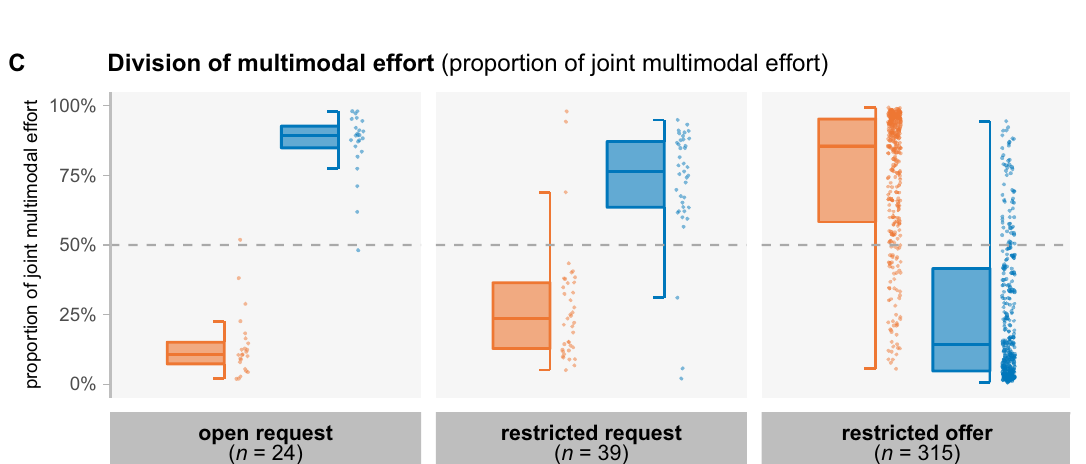
Figure 1. Boxplots showing the effort invested in the repair initiation (orange) and repair solution (blue), for repair formats of increasing specificity (open request < restricted request < restricted offer). The boxes represent the interquartile range; the middle line the median; the whiskers the minimum and maximum scores (outliers excluded). Every dot represents a repair initiation or solution. Absolute speech effort ( A ) and absolute gesture effort ( B ) both go up in repair initiations and down in repair solutions as repair formats become more specific. Proportional multimodal effort ( C ) shifts from repair initiation to repair solution as we move towards more specific repair formats. The dashed line represents equal division of effort across